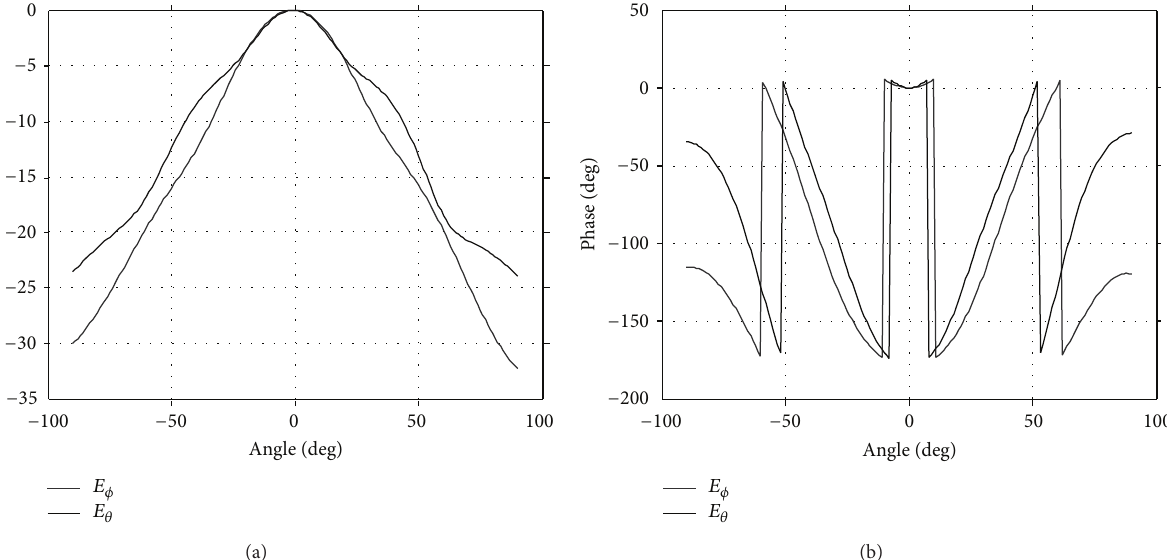
Figure 22: Near field radiation pattern of conical horn at 𝑟 = 2𝜆 (6.4cm).